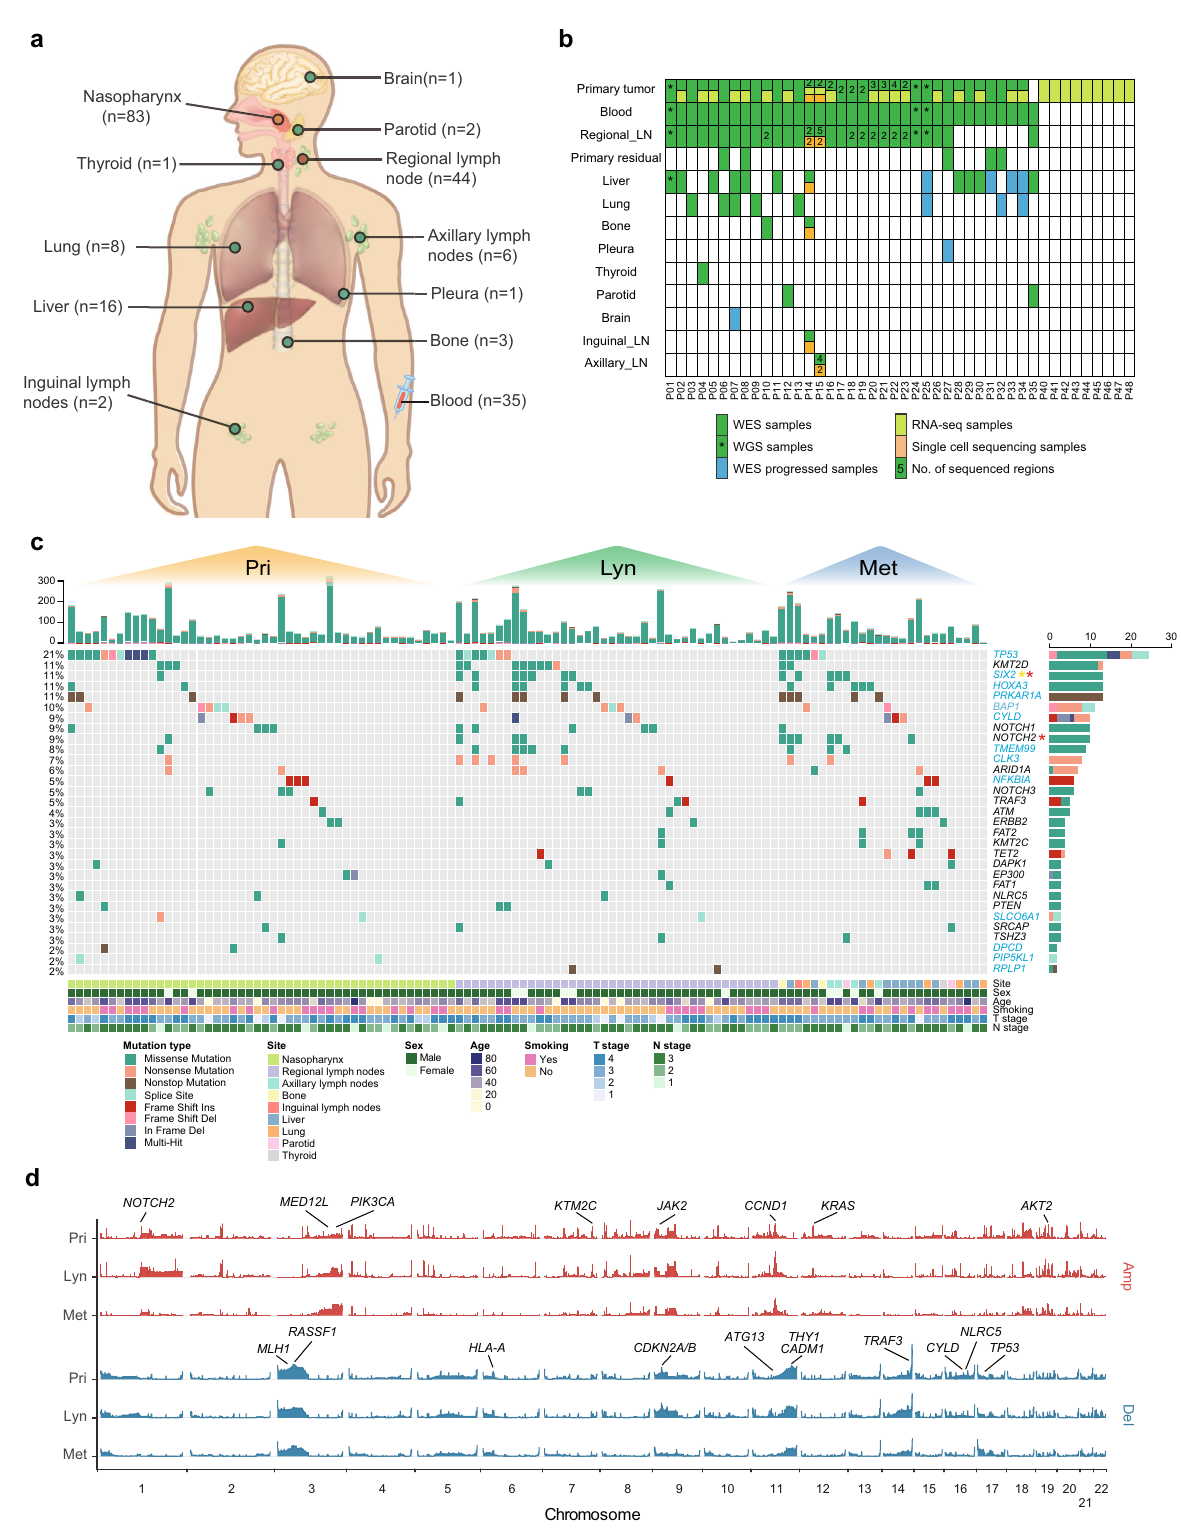
Fig. 1 | Genomic landscape of NPC primary and metastatic tumours. a Site distribution of the sequenced samples. The number of samples from each site is shown in brackets. b The sequencing strategy across all samples. c Anoverviewof somatic mutations detected in primary tumour, regional lymph node metastasis and distant metastasis samples. The top panel shows the total mutations for each sample.Themiddlepanelshowsthemutationdetailsforputativedrivergenes.The signi fi cantly mutated genes evaluated by MutSigCV are shown in blue, and the